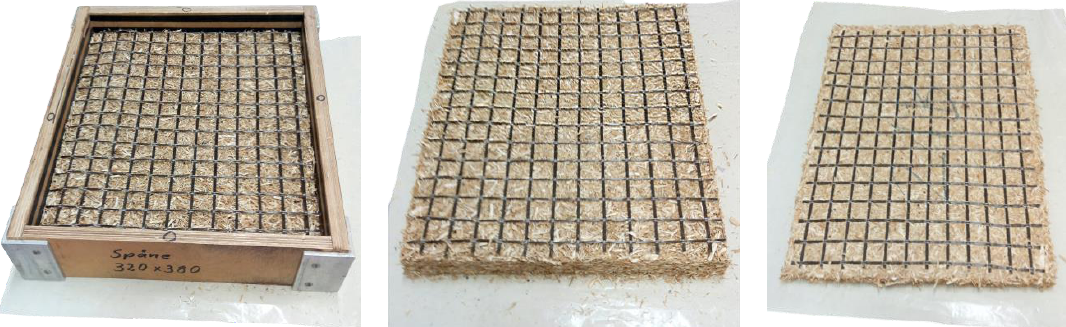
Figure 1. Lattice placed in the surface of the board. From the left: layered carpet in the form for pre-pressing, carpet after cold pre-pressing, pressed board.